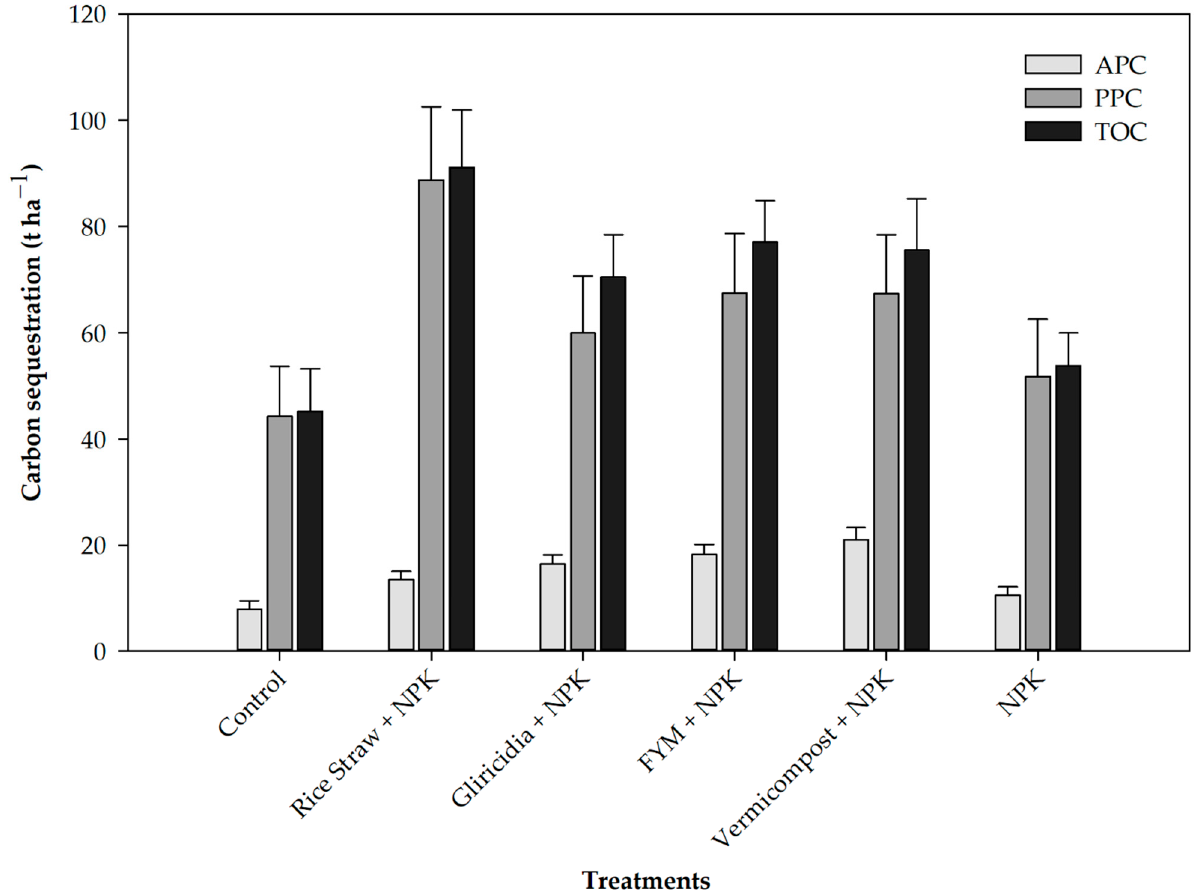
Figure 5. Effects of treatments on carbon sequestration in terms of total organic carbon (TOC), passive pool of carbon (PPC) and active pool of carbon (APC) values. The values are the averages of measurements over three crop growth stages through three consecutive crop growing seasons.